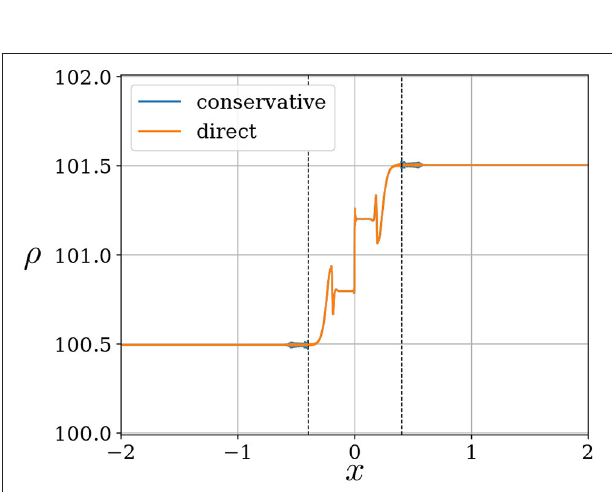
FIGURE 15 | Total plasma mass density of the small electrostatic shock test at t 1.5 with invalid MHD assumptions. Both the conservative numerical flux = coupling and direct variable translation methods are able to maintain reasonable coupling behavior, and the impedance mismatch shows up as oscillations at the model interface. The direct variable translation method seems to average over some of these oscillations to produce a visually smoother